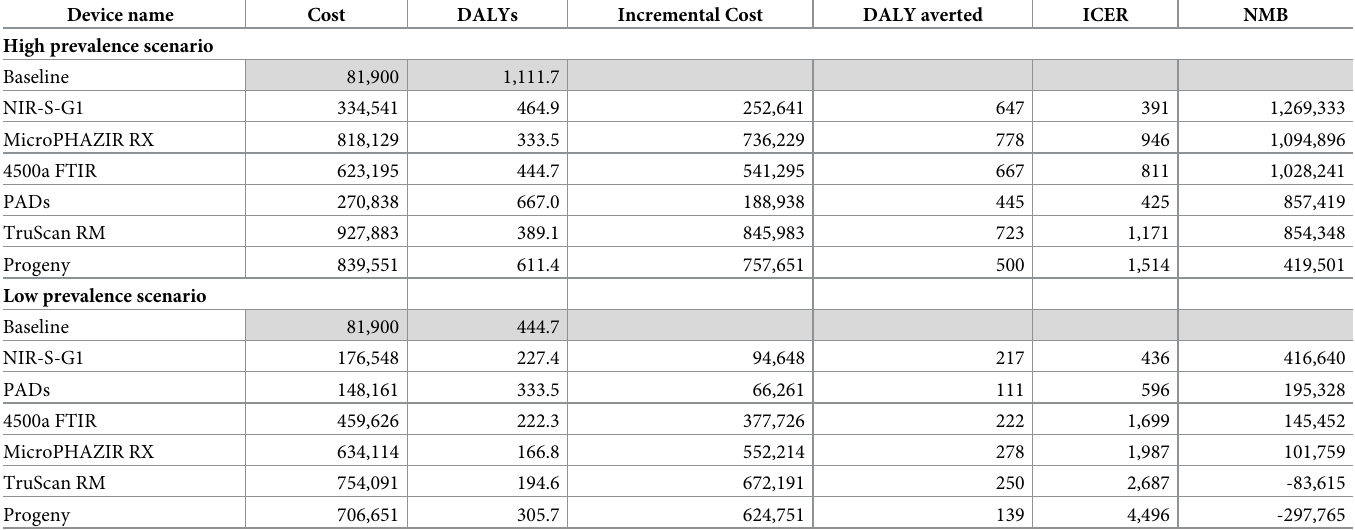
Table 5. Country level costs and effects in high and lower prevalence scenario per device with a 1-sample strategy compared with visual inspection ranked by descending net monetary benefit (NMB, US$). DALYs—disability adjusted life years. ICER—incremental cost-effectiveness